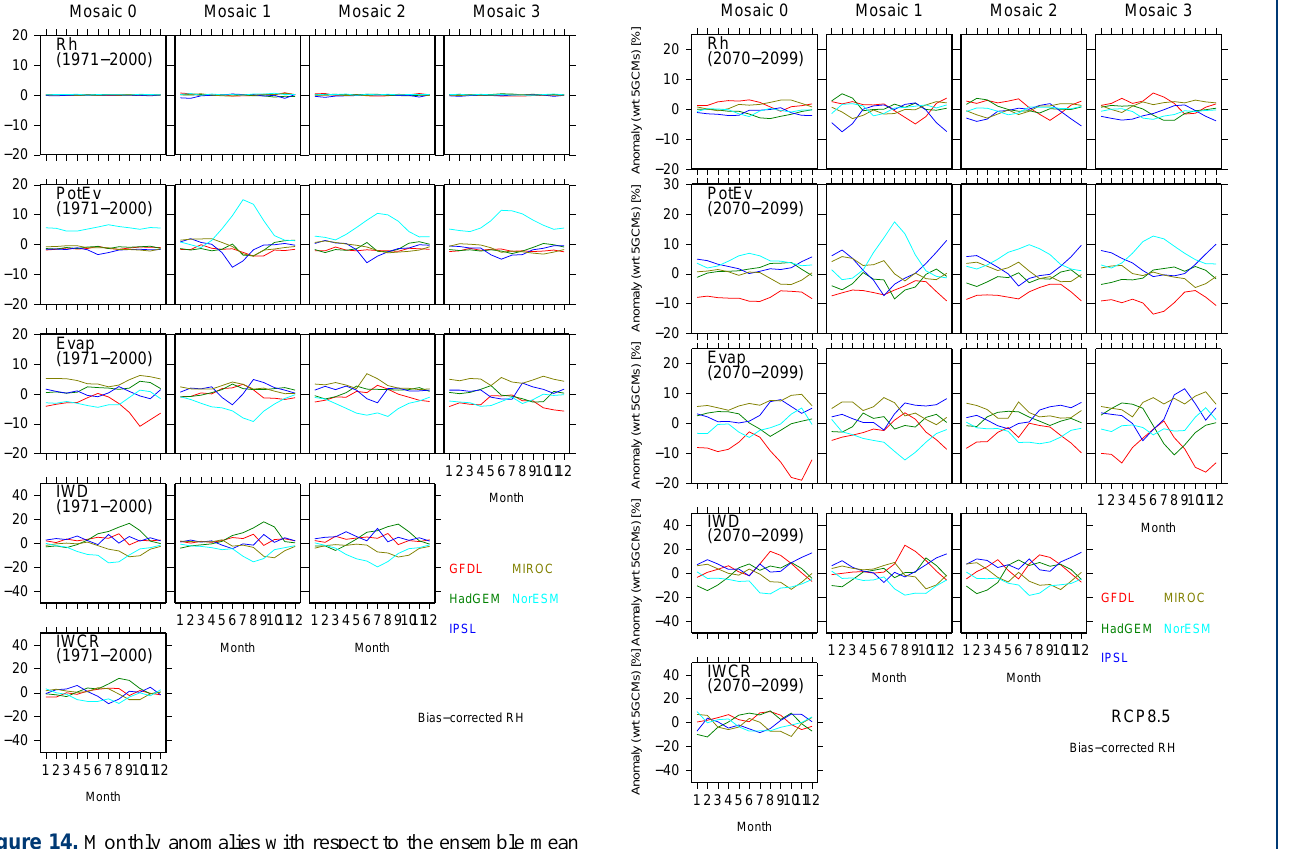
Figure 15. Same as in Fig. 14 but for the future period (2070–2099) under